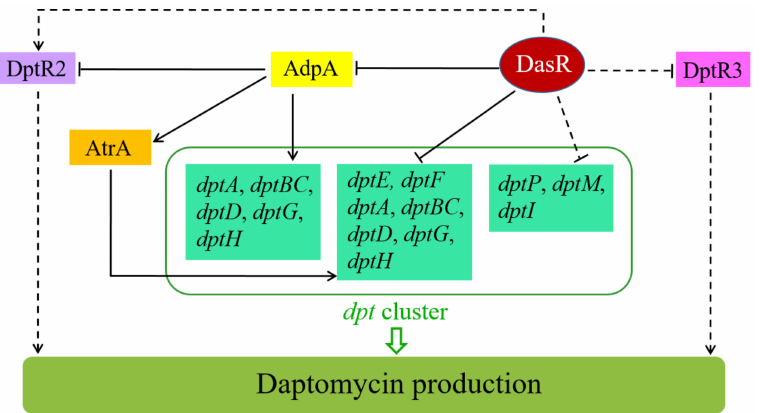
Figure 9. Proposed model of regulatory role of DasR in control of daptomycin production in S. roseosporus . Solid arrows: activation. Bars: repression. Solid lines: direct control. Dashed lines: indirect